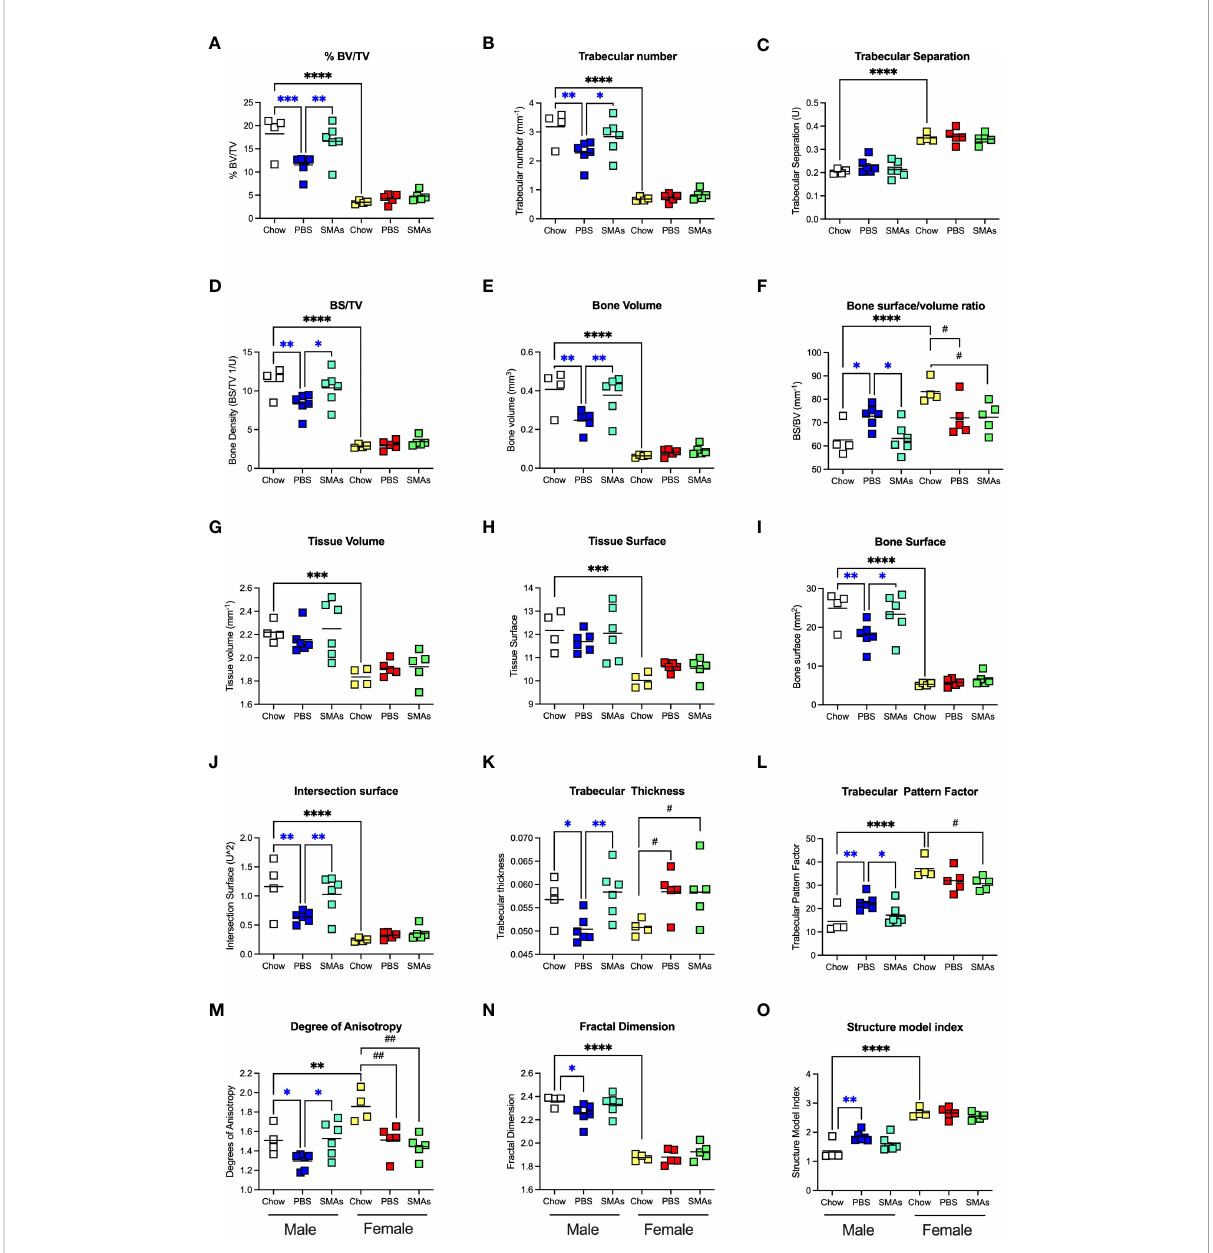
FIGURE 8 ES-62-based SMAs protect against the HCD-accelerated decline in trabecular bone structure in male HCD-fed mice. The effects of ES-62-based SMAs on the HCD (PBS)- accelerated decline in bone structure homeostasis, as evidenced by changes in the indicated parameters of trabecular architecture in femurs from Chow-, HCD-PBS (PBS)- and HCD-SMAs (SMAs) groups of male and female mice (A – O) at d160. The data shown are the values offemurs from individual mice (symbols) with the mean value for the group represented by the bar. Signi fi cant differences are indicated by blue***=p<0.001 for male PBS v male Chow, blue**=p<0.01 for male PBS v male Chow or male SMAs, and blue*=p<0.05 for male PBS v male Chow or male SMAs (A, B, D – F, I – O) ; black****=p<0.0001, black***=p<0.001 and black**=p<0.01 for male Chow v female Chow (A – J, L – O) and black ## =p<0.01 and black # =p<0.05 for female Chow v female PBS or female SMAs (F, K – M)